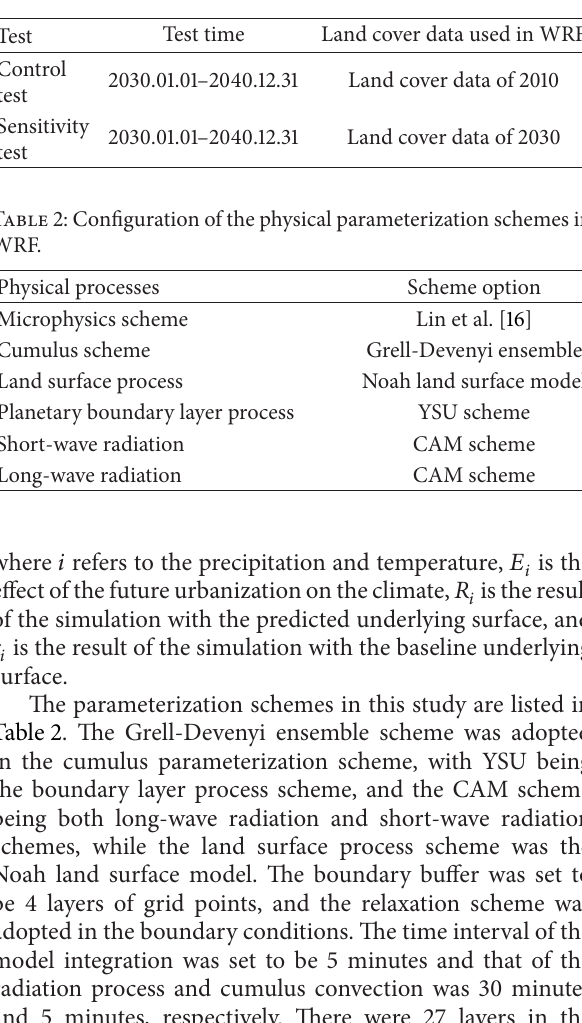
Table 1: Schemes of the simulation test.